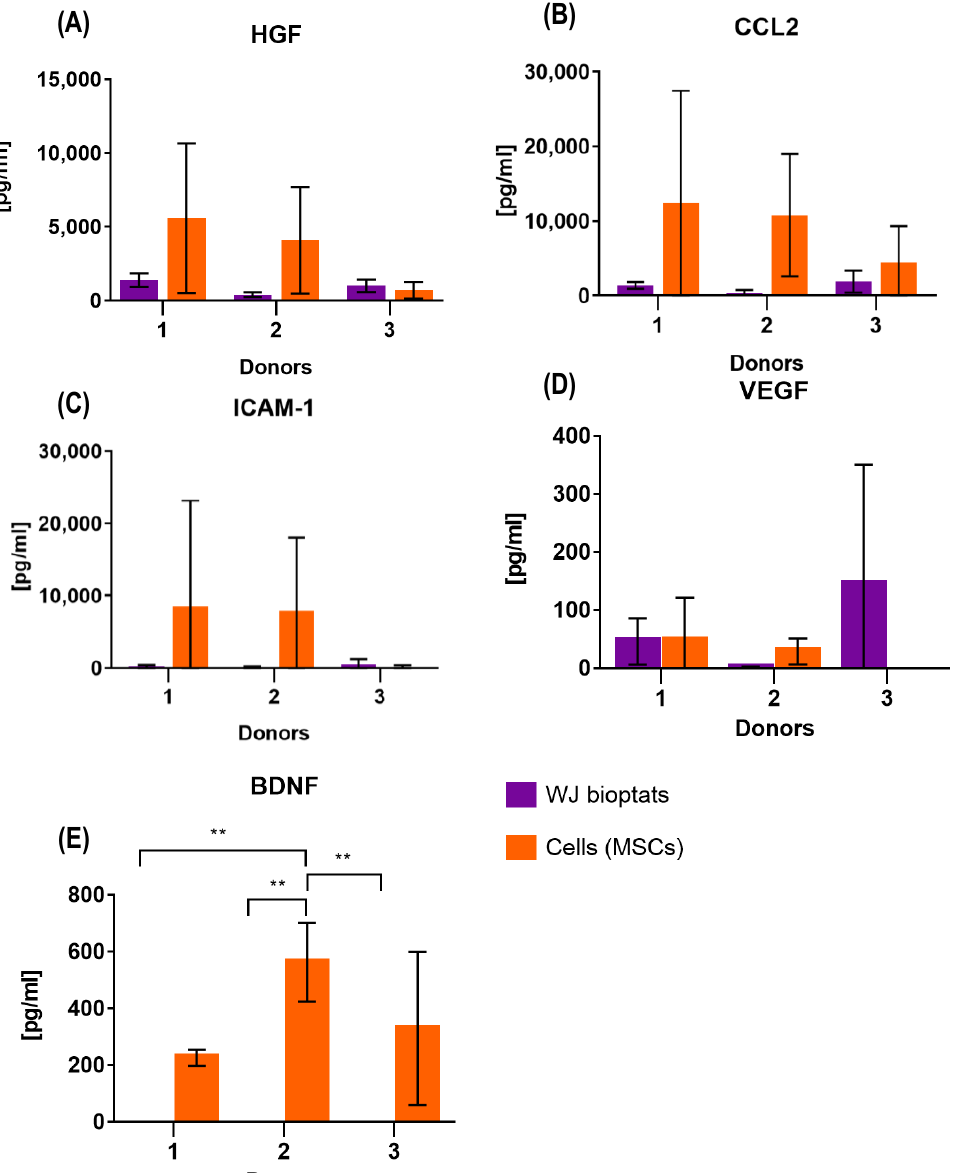
(Figure 4D). The freshly isolated tissue bioptats did not produce BDNF or beta-NGF (Figure 4E).